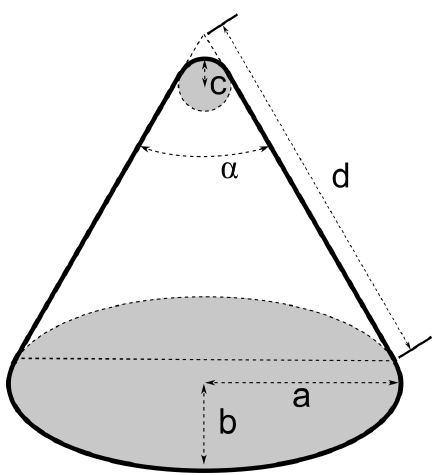
Figure 1. Two-dimensional slice through the axis of symmetry of a conical graupel particle, with the solid line representing the outline of the particle surface. The sphere with radius c , cone with apex an- gle α and height d · cos (α/ 2), and spheroid with semi-major axis a and semi-minor axis b used to build the conical graupel particle are illustrated by shaded regions (within the particle) and dashed lines. The line labeled d is tangent to both the sphere and spheroid. In this work, like in Aydin and Seliga (1984), we assume the constraints b/a = 0 . 5 and c/a = 0 . 2. The overall morphology of conical grau- pel in this representation is determined by its cone angle α and the spheroid semi-major axis a